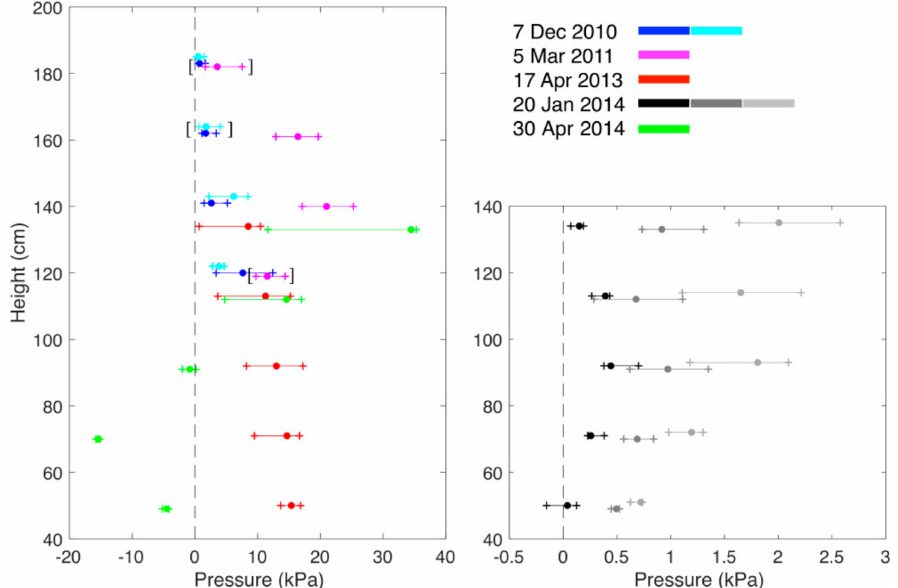
Figure 16. Vertical profiles of the pressures during the time intervals when the impacts occurred, for the five selected avalanches (data averaged over 0.2 s). The considered time intervals shown with colors are: 5.40–6.00 s (blue) and 8.10–8.90 s (light blue) for 7 December 2010; 5.65–9.20 s (pink) for 5 March 2011; 3.90–5.40 s (red) for 17 April 2013; 3.15–3.76 s (black), 5.35–7.30 s (grey), and 23.75–26.36 s (light grey) for 20 January 2014; 4.25–7.70 s (green) for 30 April 2014. The symbols show the median values within the considered time intervals and the bars represent the 25th and 75th percentiles. In squared brackets are the values related to inoperative sensors (see text for